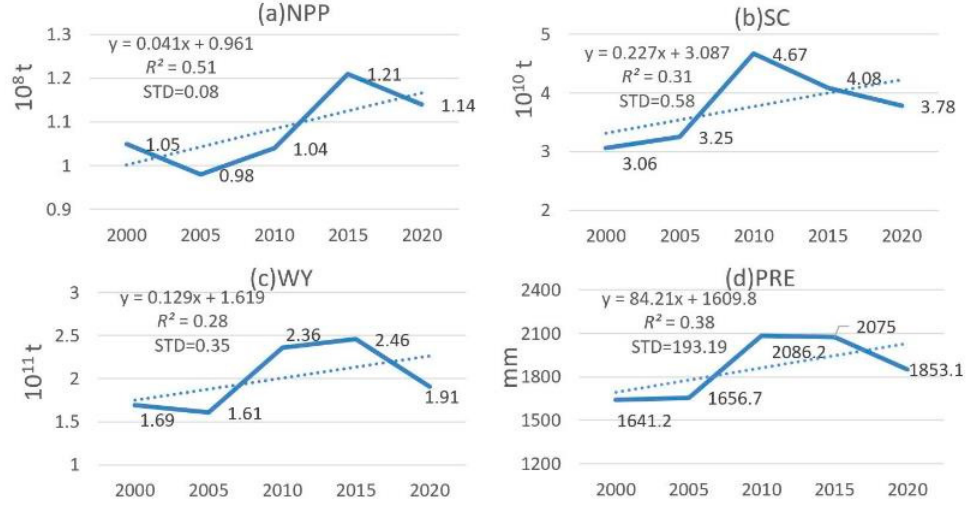
Figure 2. The temporal changes in three ecosystem services and precipitation from 2000 to 2020: ( a ) net primary productivity (NPP); ( b ) soil conservation (SC); ( c ) water yield (WY); ( d ) precipitation (PRE).